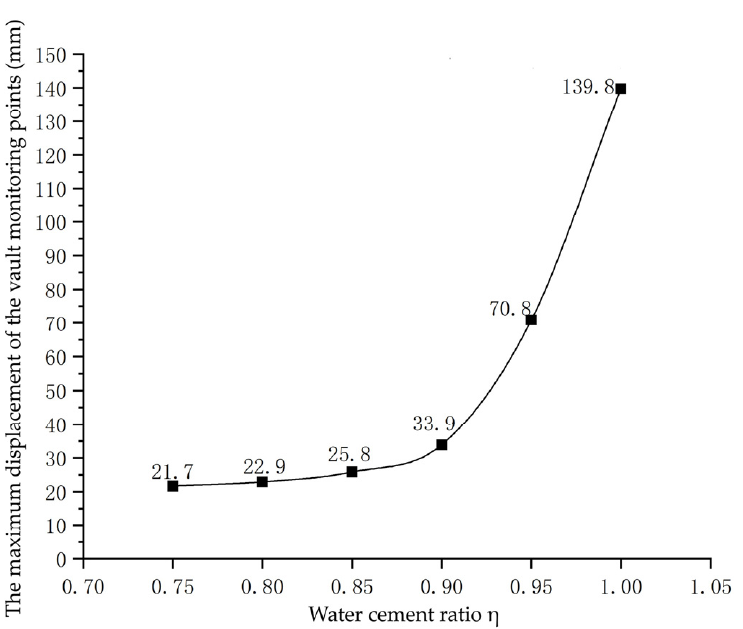
Figure 22. Relationship between the maximum displacement of monitoring points on the vault and water–cement ratio.